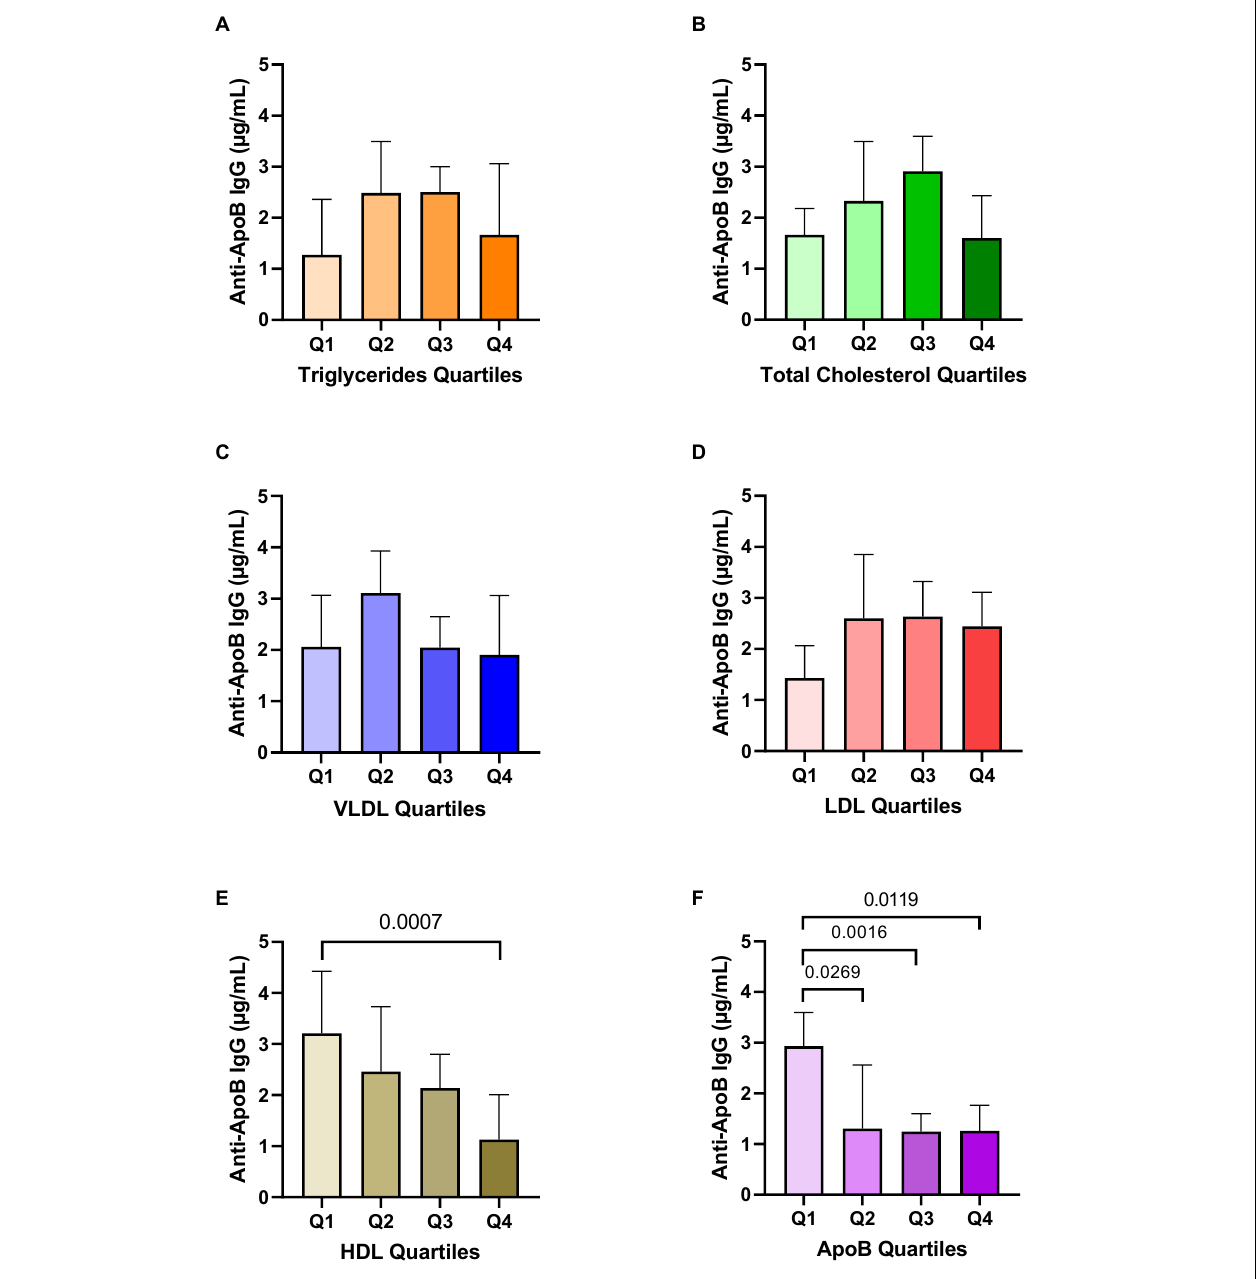
FIGURE 4 | Associations of anti-ApoB IgG plasma levels with triglycerides, cholesterol, and apolipoproteins. Anti-ApoB IgG plasma levels were quantified by ELISA and divided into quartiles (Q) of patient plasma levels of (A) triglycerides, (B) total cholesterol, (C) VLDL, (D) LDL, (E) HDL, and (F) ApoB. VLDL, very low-density lipoprotein; LDL, low-density lipoprotein; HDL, high-density lipoprotein. Data are presented as median ±